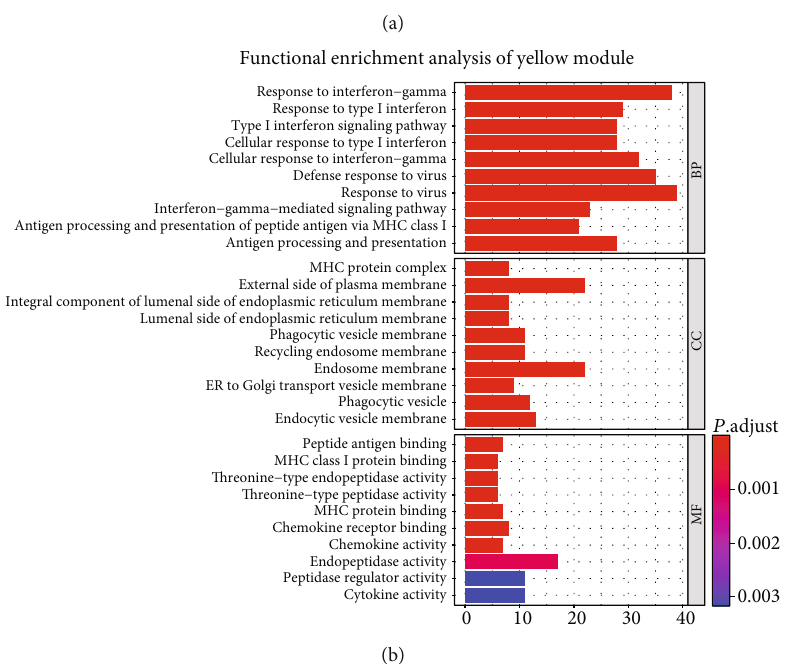
Figure 3: Functional enrichment analysis. (a) Functional enrichment analysis of the green-yellow module. In the biological process, essential genes are enriched in cells ’ response to transforming growth factor stimulation. (b) Functional enrichment analysis of the yellow module. In the biological process, the essential genes are concentrated in IFN- γ -mediated signaling pathway and antigen processing and